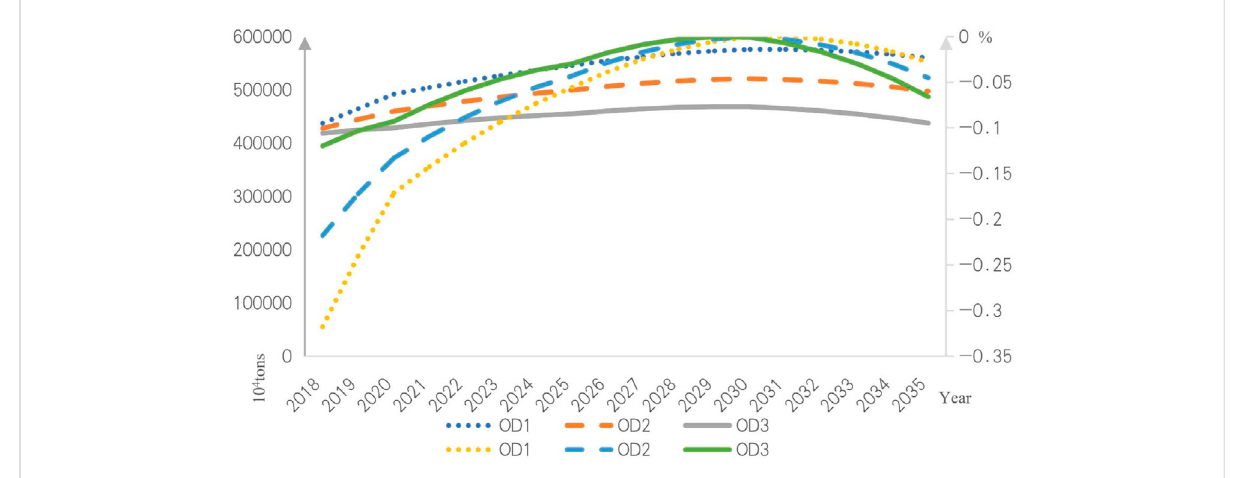
FIGURE 4 Coal consumption and growth trend in China under conservative development scenario from 2018 to